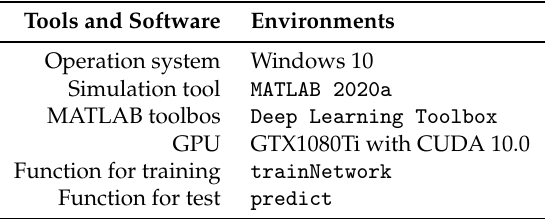
Table 2. Simulation software